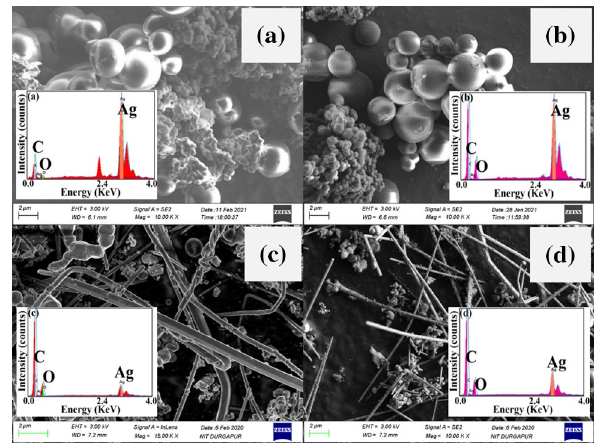
Fig. 2 FESEM image of a Ag/C-5, b Ag/C-10, c Ag/C-15, d Ag/C-20. Their corresponding EDX patterns are given in the inset of FESEM images